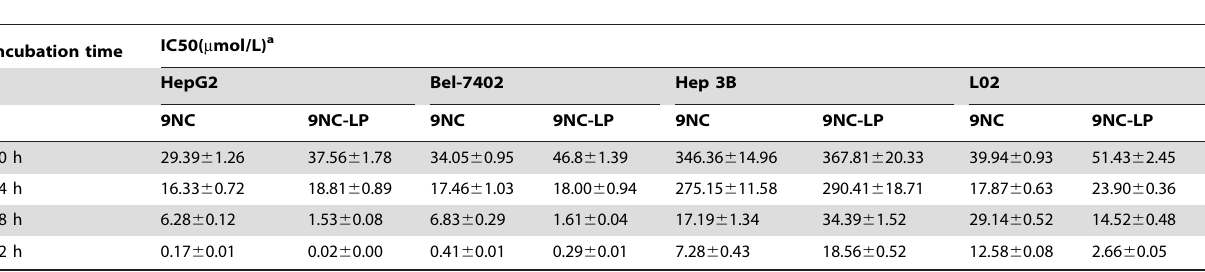
Table 2. Cell growth inhibitory activity of 9NC and 9NC-LP in human cancer and normal cells.